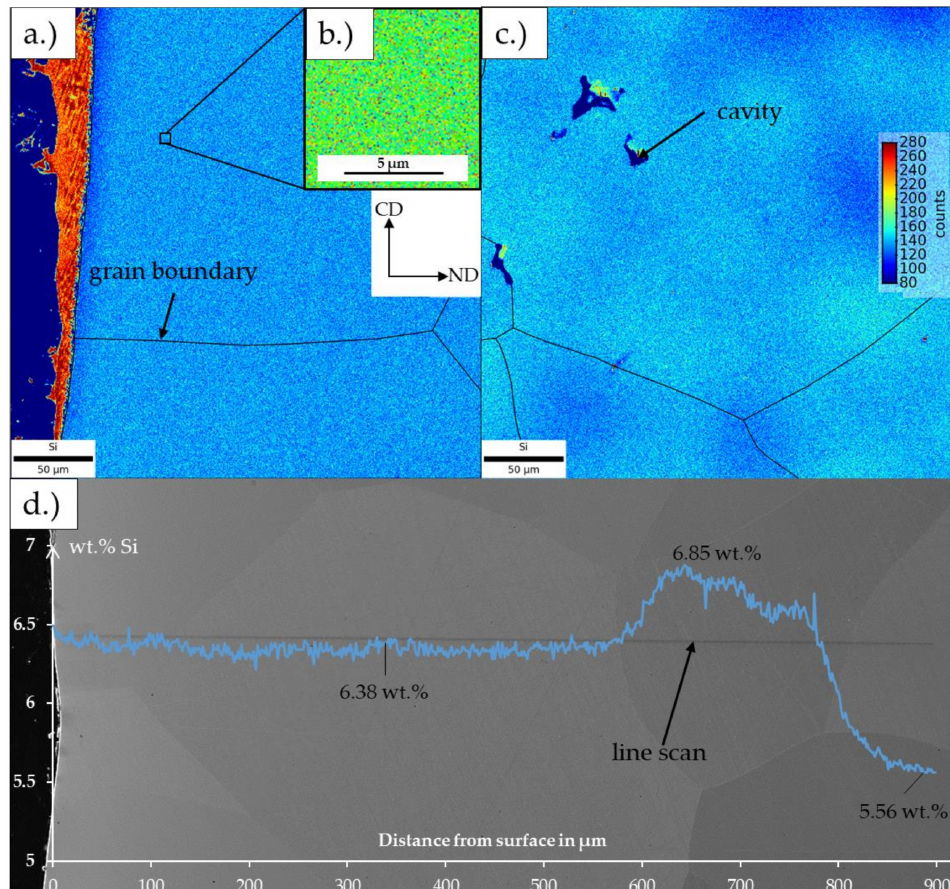
Figure 1. Results of EPMA scans for Si measured at sample AC1378. ( a ) Map scan with overlaid grain structure at the edge of the sheet with step size 0.5 µ m and ( b ) the magnified area detected with a step size of 22.5 nm; ( c ) map scan overlaid grain structure in the middle of the sheet; ( d ) line scan over the half thickness of the sheet with the corresponding SEM-picture in the background. (Image source: GfE RWTH